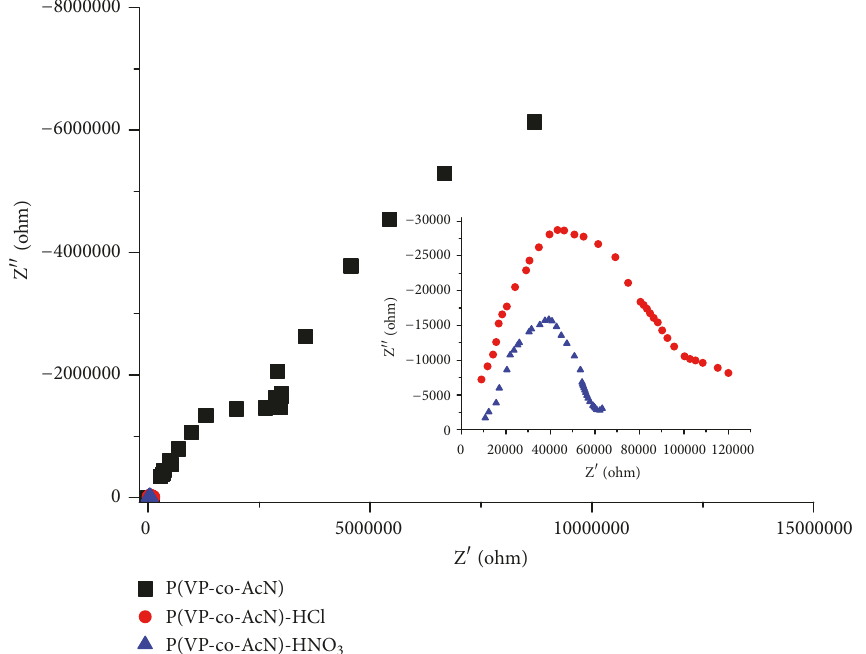
Figure 14: Complex-impedance plots at 30 ∘ for P(VP-co-AcN), P(VP-co-AcN)-HCl, and P(VP-co-AcN)-HNO 3 , respectively.